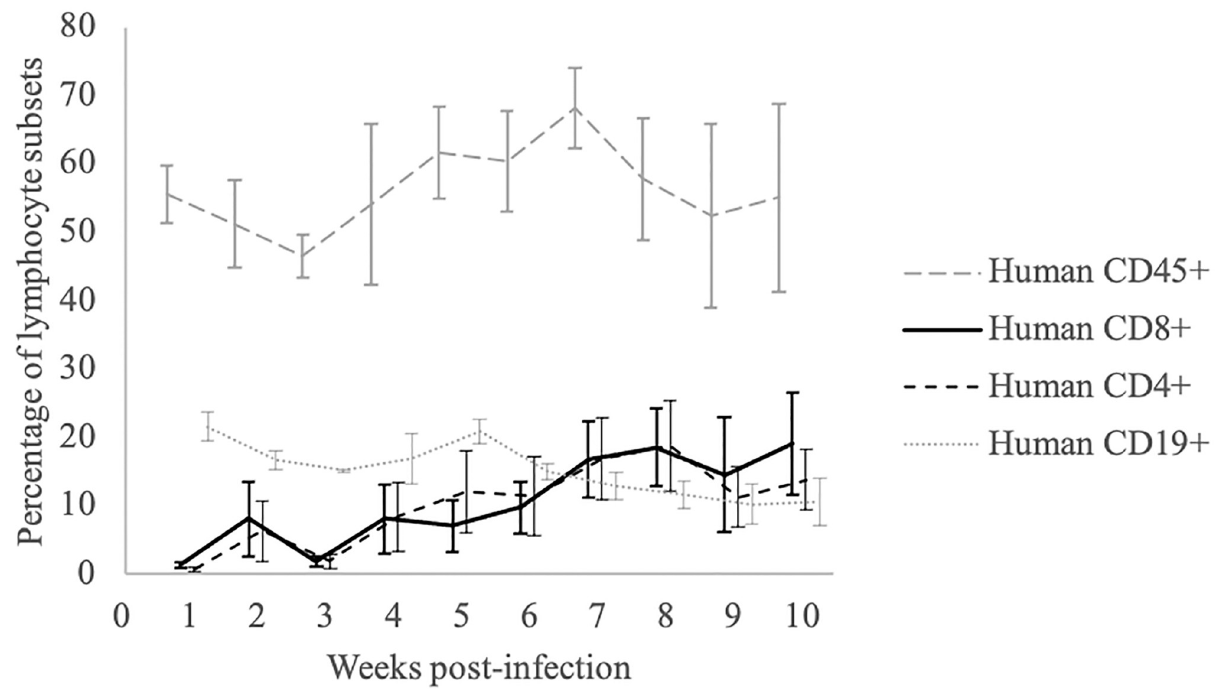
Fig 1. Time course of human lymphocyte reconstitution in peripheral blood of EBV-infected hu-NOG mice. Following inoculation with EBV, the percentages of human CD45 + , CD4 + , CD8 + , and CD19 + cells among the peripheral blood mononuclear cells were measured weekly. Upon EBV infection, the percentage of human CD8 + T cells increased rapidly, and the ratio of CD4 + cells to CD8 + cells decreased to below 1. Values represent mean ± standard error.